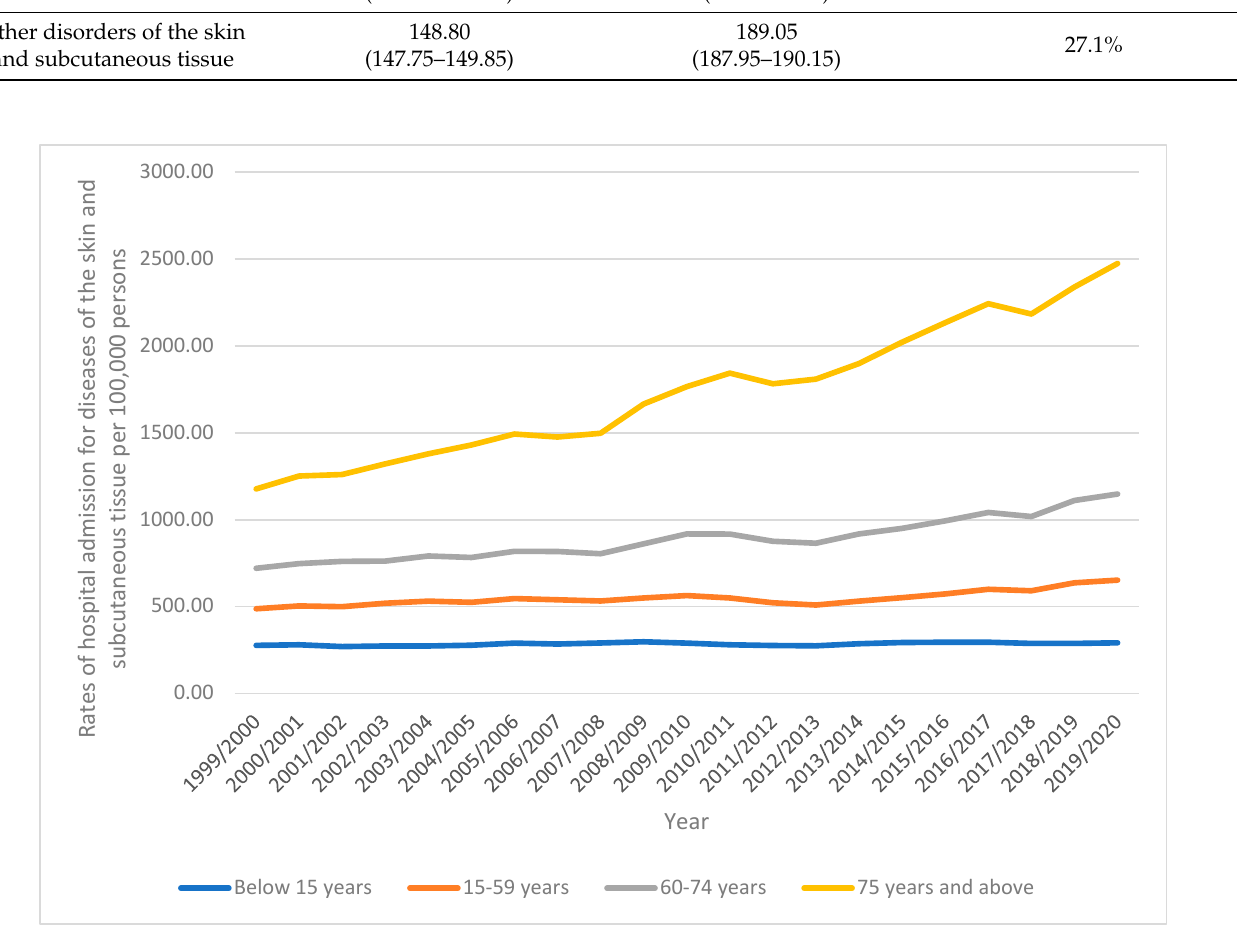
Figure 2. Rates of hospital admission stratified by age group.